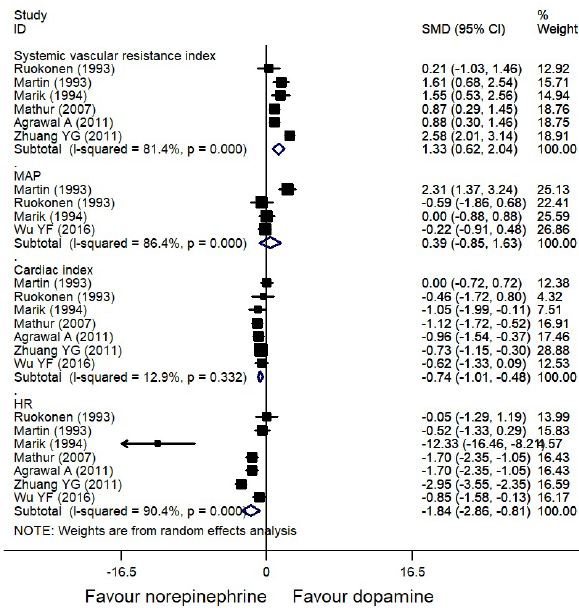
Figure 4: The forest plot of hemodynamics index for norepinephrine versus dopamine in treatment of septic shock.